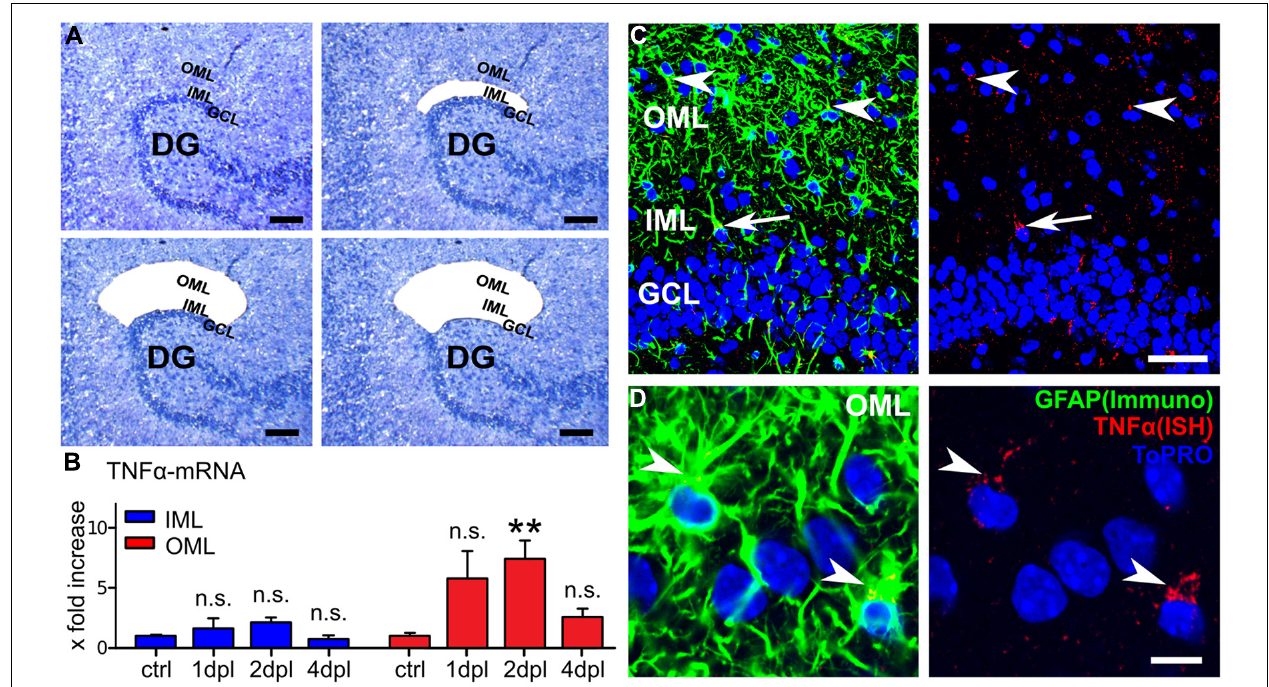
FIGURE 4 | Laser capture microdissection combined with qPCR reveals changes in TNF α -mRNA levels following entorhinal denervation in vitro . (A) Laser capture microdissection (LMD) was employed to collect tissue from the inner molecular layer (IML; top right side), the outer molecular layer (OML; bottom left side), and the granule cell layer (GCL; bottom right side) of denervated cultures (at 1, 2, and 4 dpl) and non-denervated control cultures. (B) TNF α -mRNA levels were assessed in the isolated tissue using qPCR. An increase in TNF α -mRNA was observed in the OML at 2 dpl. TNF α -mRNA levels in the IML were not significantly changed. In the GCL TNF α -mRNA levels were below the detection threshold and no quantitative analysis of this layer was performed ( n = 4–7 cultures per group). Data